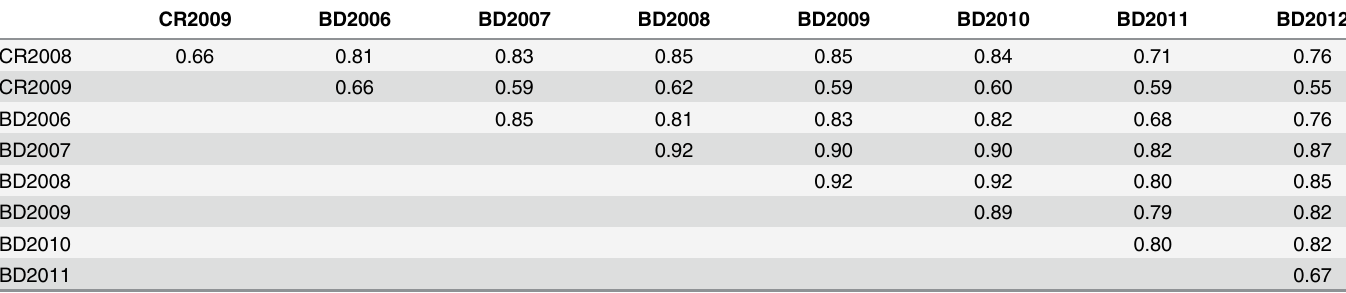
Table 1. Spearman ’ s rank order correlation coefficients for observed chilling requirement (CR) and bloom date (BD).